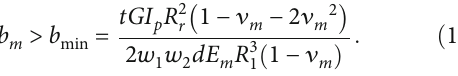
Figure 4: Schematic illustration of the membrane deformation after coiling.